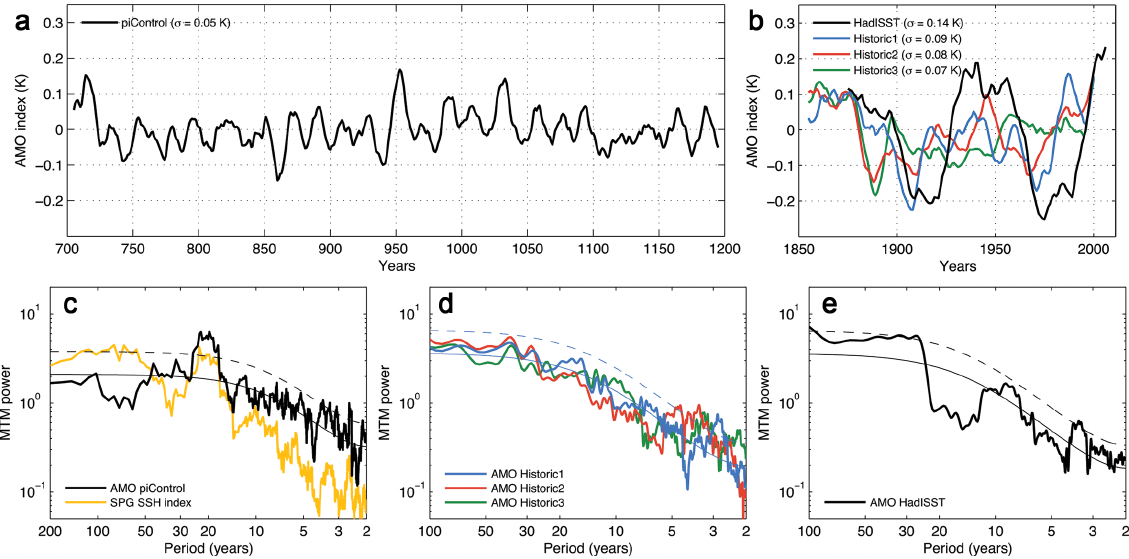
Fig. 23. (a) Time series of AMO index defined as annual detrended SST anomalies for the region 75 ◦ W–7 ◦ W, 0 ◦ –60 ◦ N in NorESM piControl and (b) HadISST (black line) together with NorESM historical ensemble members (blue, red, and green lines). Lower panels show power spectra of (c) NorESM piControl AMO index (black line) and subpolar gyre SSH index (anomalous SSH for the region 60 ◦ W–15 ◦ W, 48 ◦ N–65 ◦ N; yellow line), (d) NorESM historical ensemble members (colours as in b ), and (e) HadISST. The multitaper method of Ghil et al. (2002) with resolution p = 4 and number of tapers t = 7 is applied to time series normalized by their standard deviation. Thin lines represent fitted red noise spectra of the power spectra with the same colour. The dashed lines are the 95% confidence limits about the red noise spectra.